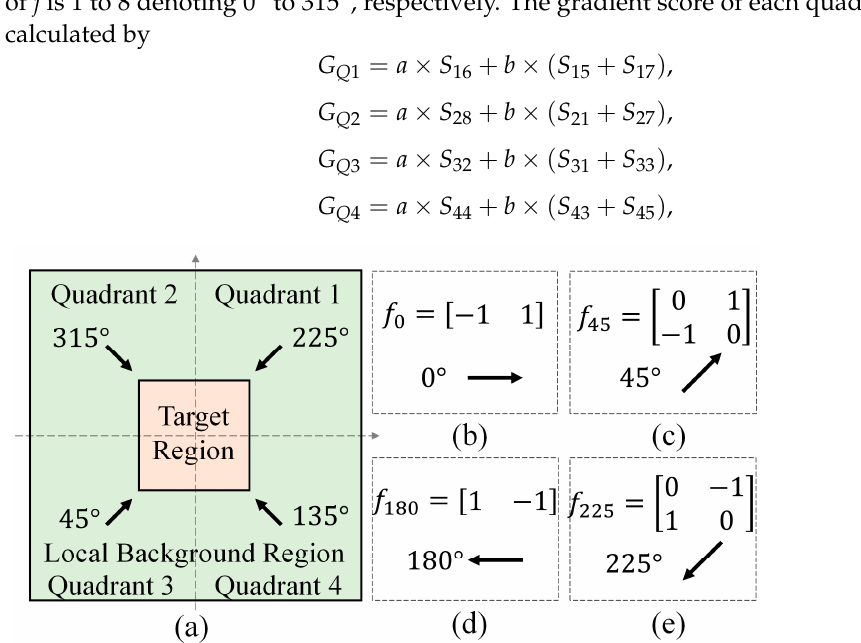
Figure 5. ( a ) Illustration for the operation region for the gradient analysis; ( b – e ) gradient filters for different directions.